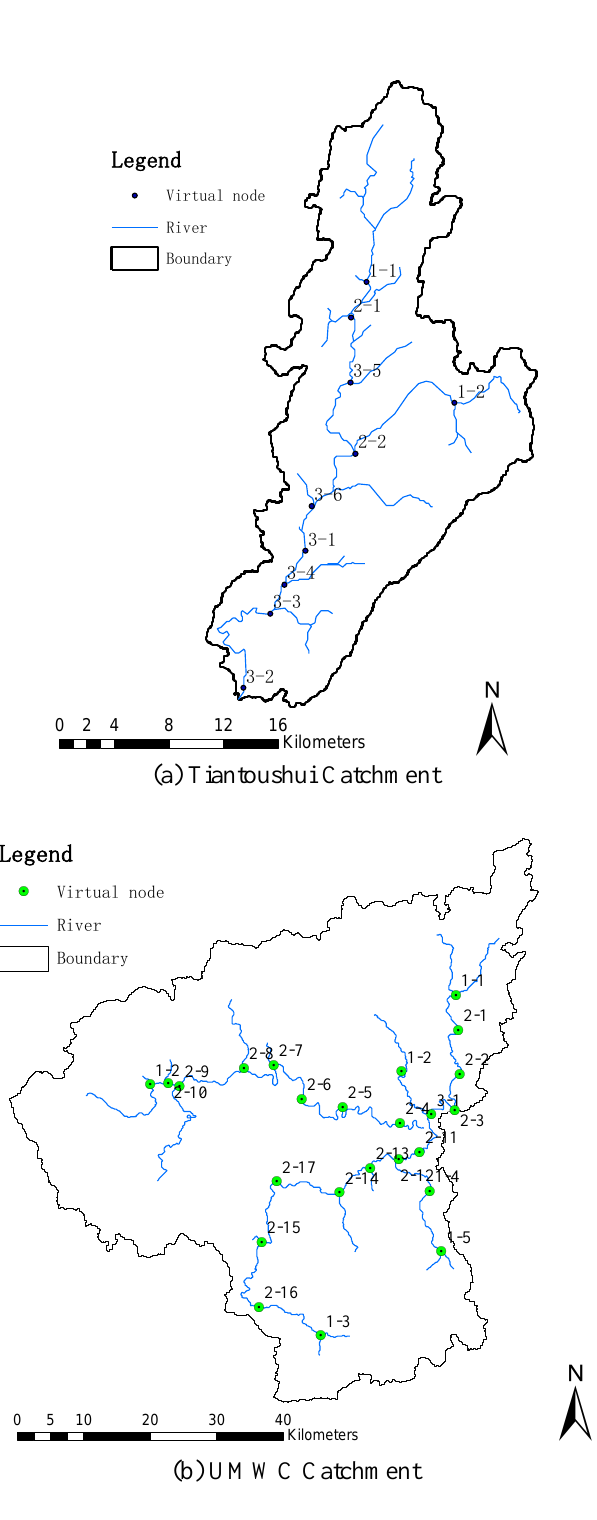
Figure 4. Model setup results: (a) Tiantoushui catchment and (b) UMWC catchment.